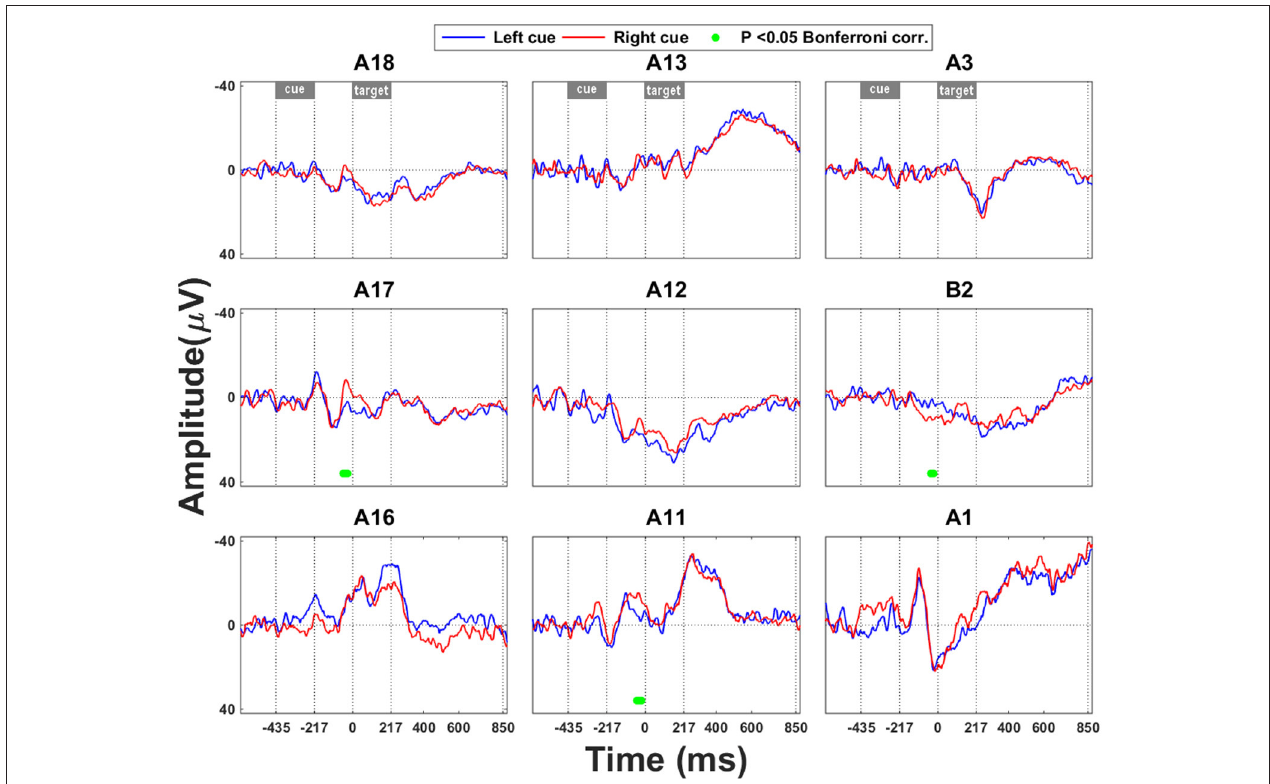
FIGURE 2 | Leftward vs. rightward cueing trials: ERP analysis. Significant effects that occur in the interval between cue onset and grating onset are marked by a green bar. Time point 0 refers to the onset of the grating. The significance threshold is set at P < 0.05 corrected for the number of electrodes during a minimum continuous period of 10 ms. The plots for the different electrodes are positioned in accordance with their position on the cortical surface ( Figure 1A ).